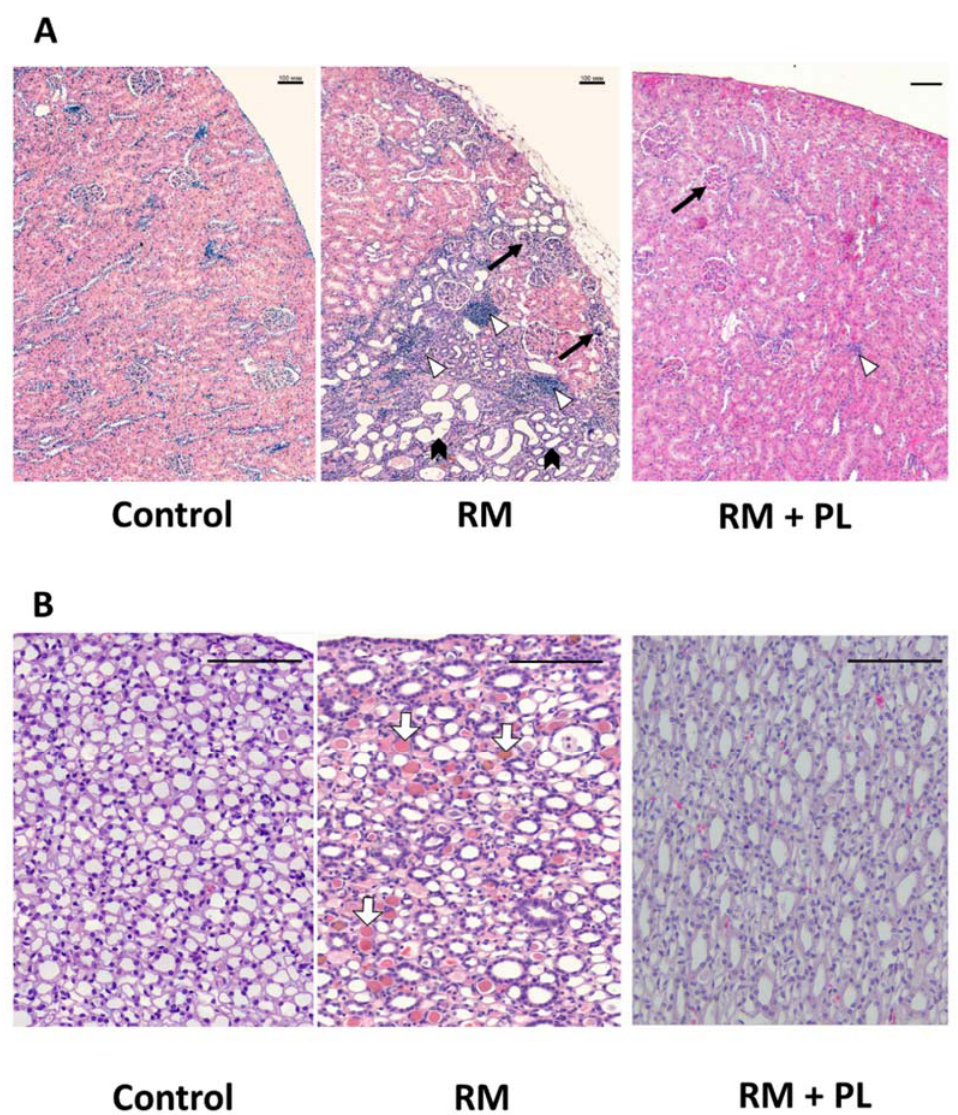
Figure 2. Morphology of the rat kidney cortex in the control group, after rhabdomyolysis (RM) and during rhabdomyolysis with administration of PL (RM + PL). ( A ) Rhabdomyolysis caused pronounced mononuclear infiltration in the cortex (white arrowheads), dilatation of tubules (black arrowheads), glomerular sclerosis (black arrows), and hyaline casts (white arrows). PL reversed these changes. Scale bar, 100 μ m. ( B ) The inner part of the kidney medulla. In the RM group, note multiple protein casts (white arrows) in the lumen of Henle loops and collecting ducts. Such masses were incomparably less common after PL treatment.